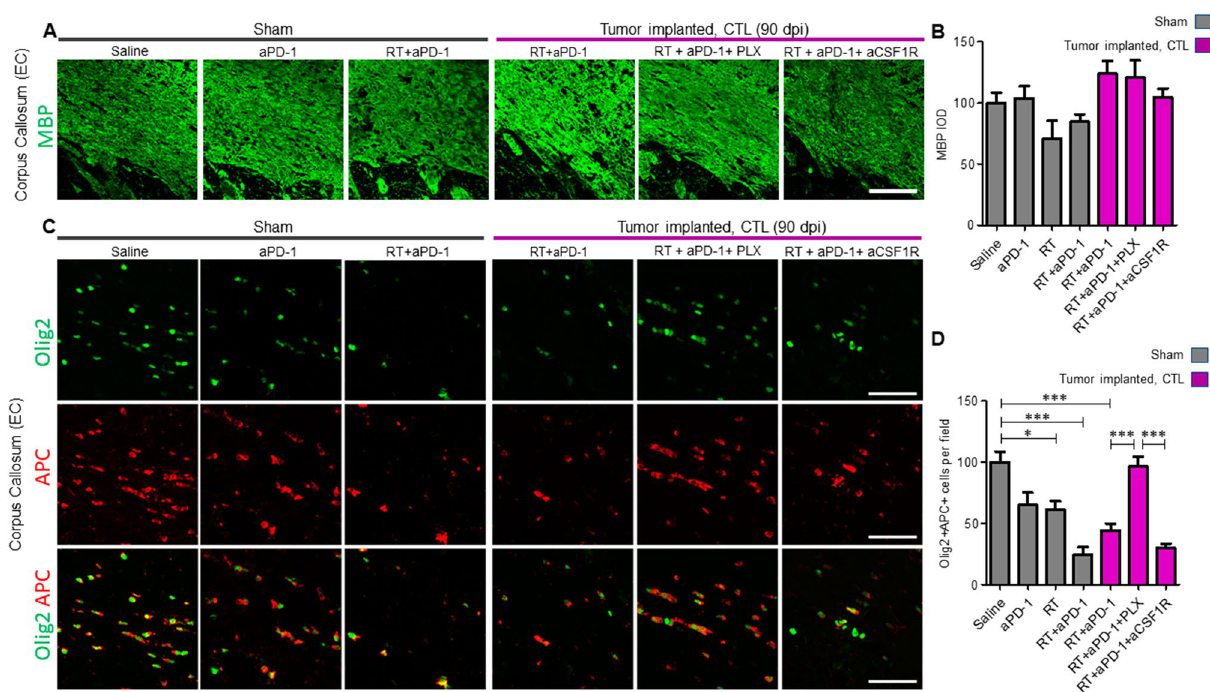
Figure 5. Microglia elimination prevented the loss of mature oligodendrocyte cells after RT + aPD-1 treatment. ( A ) Representative confocal micrographs of the external capsule of the corpus callosum (EC) stained for MBP in sham operated mice and tumor implanted mice for the indicated experimental groups. Samples were collected at 90 dpi and images taken from the contralateral hemisphere (CTL). Scale bar = 50 µm. ( B ) Quantification of MBP IOD in the EC. ( C ) Confocal images of the EC immunostained for Olig2 and APC for the experimental groups in panel A. Colocalization of both markers is also shown. ( D ) Quantification of mature oligodendrocytes assessed by Olig2 and APC double immunoreactivity in the EC. n = 6 per treatment arm in sham mice and n = 6 RT + aPD-1 + saline, n = 3 RT + aPD-1 + PLX5622 and n = 3 RT + aPD-1 + aCSF1R in tumor implanted mice, * P < 0.05 and *** P < 0.001 by ANOVA followed by Tukey’s multiple comparison